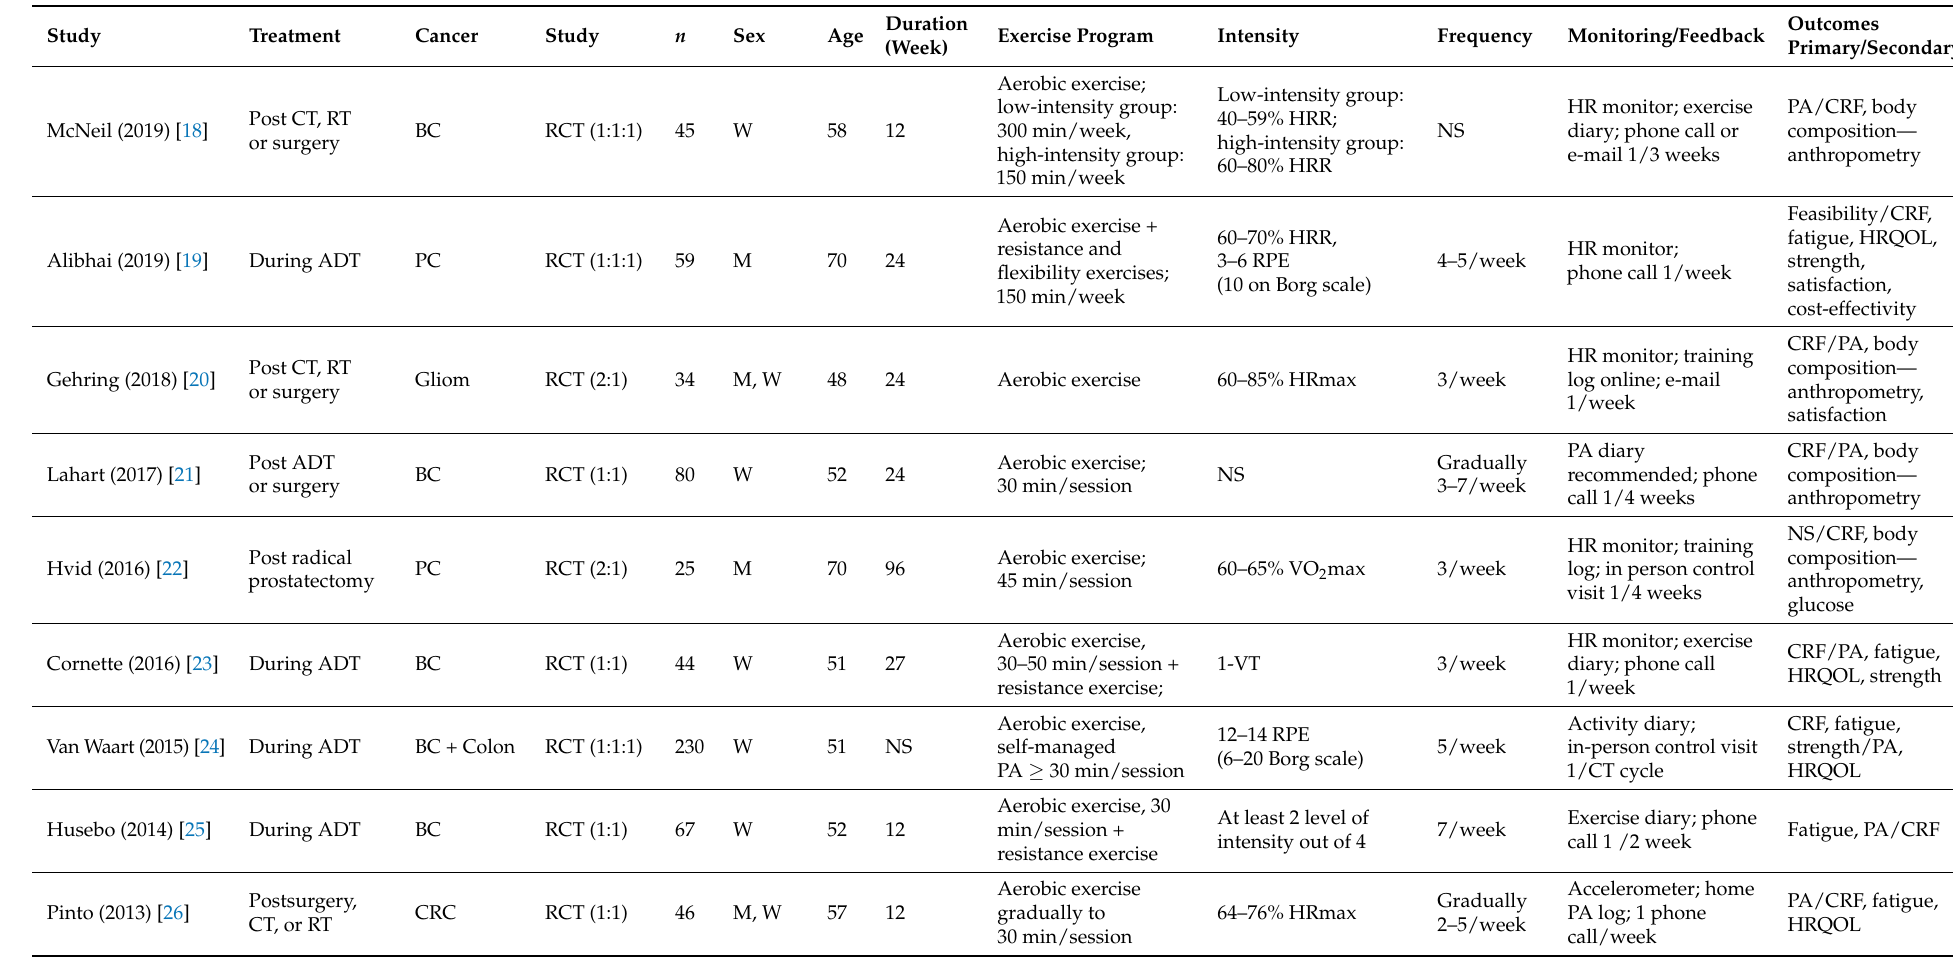
Table 1. Characteristics and results of studies that evaluated the effects of home-based (HB) exercise